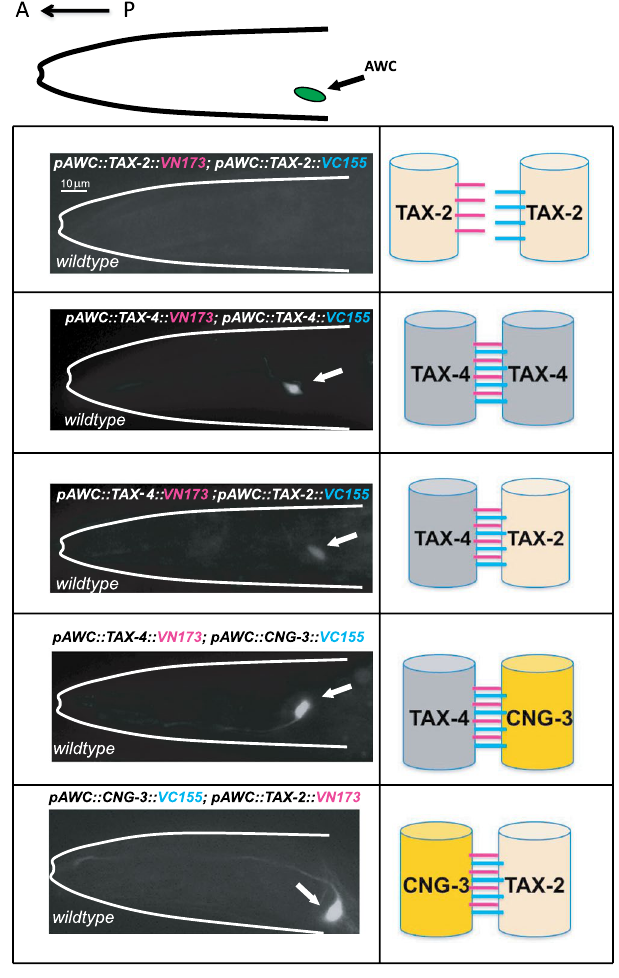
Figure 4. Biomolecular fluorescence complementation (BiFC) assays reveal an in vivo interaction between CNG-3 with TAX-2 and CNG-3 with TAX-4. The cartoon at the top illustrates the orientation of the animal for all image panels with anterior to the left and the position of the AWC neuron cell body indicated. All images were captured using a confocal microscope (Zeiss) at 63X magnification. The cartoon on the right of each image indicates the CNG channel subunit pairing that is being tested. For all BiFC experiments, the CNG channels subunit are exclusively expressed in the AWC neurons. The first microscope image tests an in vivo interaction between TAX-2 tagged with the N-terminal of fluorescent Venus and also TAX-2 tagged with the C-terminal of fluorescent Venus. No interaction was observed using the TAX-2::VN173 and TAX-2::VC155 pairing. Next, a similar experiment was performed using TAX-4 tagged with the N-terminal of Venus and TAX-4 tagged with the C-terminal of Venus. In this case a signal was detected in the AWC cell body indicated by a white arrow-head (39% of the transgenic animals exhibited the BiFC signal). In the next combination the pairing of TAX-4 tagged with the N-terminal of Venus and TAX-2 tagged with the C-terminal of Venus was tested, and again a signal was detected in the cell body of AWC (22% of the transgenic animals exhibited the BiFC signal). Next an in vivo interaction was assayed between CNG-3 tagged with the C-terminal of Venus and TAX-4 with the N-terminal of Venus, and a robust signal was observed in the cell body and dendrite of AWC (61% of the transgenic animals exhibited the BiFC signal). Finally, the pairing of CNG-3 tagged with the C terminal of Venus and TAX-2 tagged with the N-terminal of Venus was tested and again a string signal was observed in the cell body and dendrite of the AWC neuron indicated by the white arrow (43% of the transgenic animals exhibited the BiFC Bimolecular fluorescence complementation assays reveal an in vivo interaction between CNG-3 with TAX-2 and CNG-3 with TAX-4. To probe the subunit composition of the native CNG channel in AWC, we used Biomolecular Fluorescence Complementation (BiFC) assays 21, 22, 26 to test for an in vivo interaction between CNG-3 with other CNG channel subunits (Fig. 4). The basic strategy of BiFC is to split a fluorescent pro- tein into two non-fluorescent fragments that are fused to a pair of interacting proteins. The interaction between the two proteins brings the two fragments into close proximity, allowing reconstitution of an intact fluorescent protein. The fluorescent protein being split in these experiments is Venus, and in the top panel of Fig. 4, a car- toon depicts the orientation of each of the BiFC images below as well as the position of the AWC cell body (in all